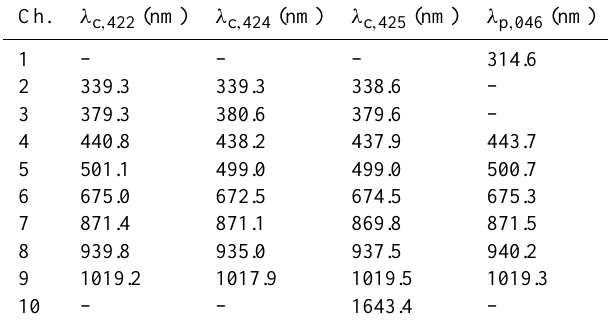
Table 1. Relation of wavelengths corresponding to central maxi- mum for the filters employed by the CIMEL (units 422, 424 and 425) and PREDE sky radiometers (unit 046).